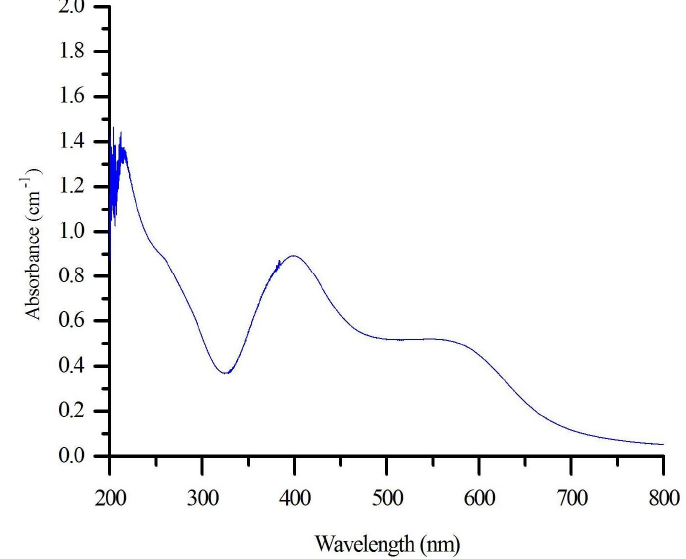
Fig. 4. UV-Visible spectrum of synthesized SNPs mediated by aqueous fruiting body extract of G.